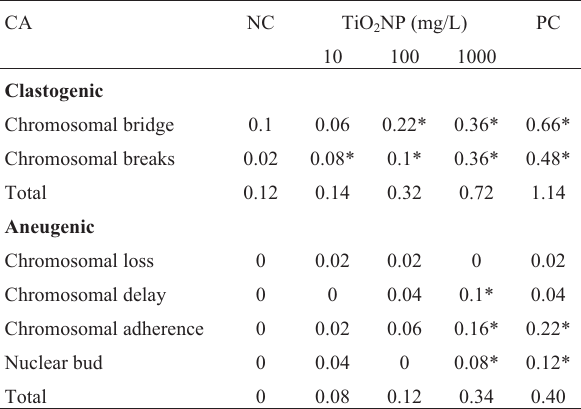
Table 1 - Seed germination and root growth inhibition of Allium cepa test system exposed to titanium dioxide nanoparticles (TiO 2 NP). Treatment